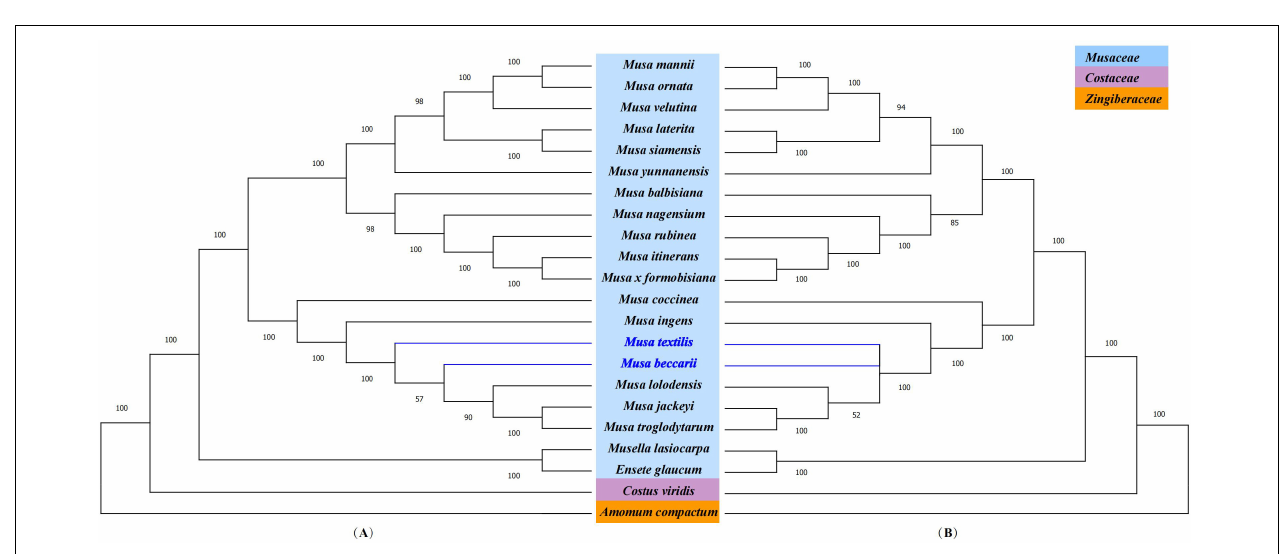
FIGURE 5 | Nucleotide diversity in chloroplast genomes of nine species of Musa . The abscissa represents the position, and the red line represents the average of the nucleotide variations of the nine species (Pi).